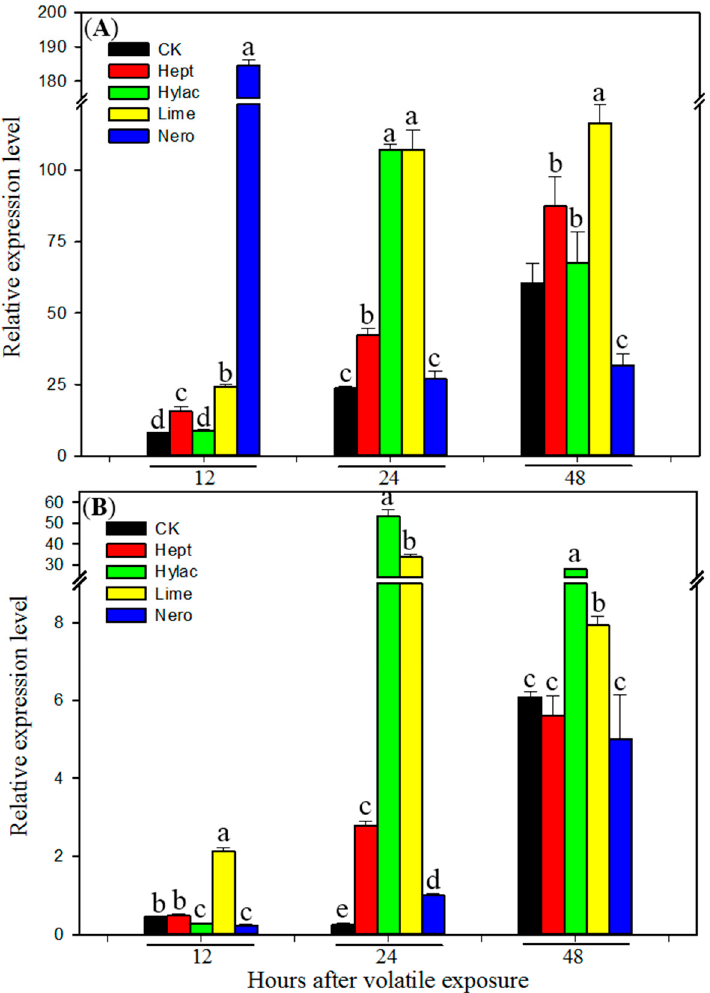
Figure 3. Transcript levels of CYP6B6 in midguts ( A ) and fat bodies ( B ) of fifth instar larvae of Helicoverpa armigera exposed to plant volatiles. Newly molted fifth instars were individually exposed to volatile 2-heptanone (Hept), cis -3-hexenyl acetate (Hylac), limonene (Limo) and nerolidol (Nero) at a dose of 1 µL per cup for 12, 24 or 48 h, respectively in a sealed cup. Then the midguts and fat bodies were dissected. Total RNA was pooled from midguts or fat bodies of 20 fifth instar H. armigera larvae exposed to different plant volatile for 12, 24 and 48 h. Control larvae (CK) were fed with diet without plant volatile. Real-time qRT-PCR analysis was conducted to determine the relative transcript levels of the gene. Data shown are means ± SE derived from three biological repeats ( n = 3). Different letters above bars indicate significant differences ( p < 0.05 using ANOVA followed by a Tukey test for post-hoc comparison).